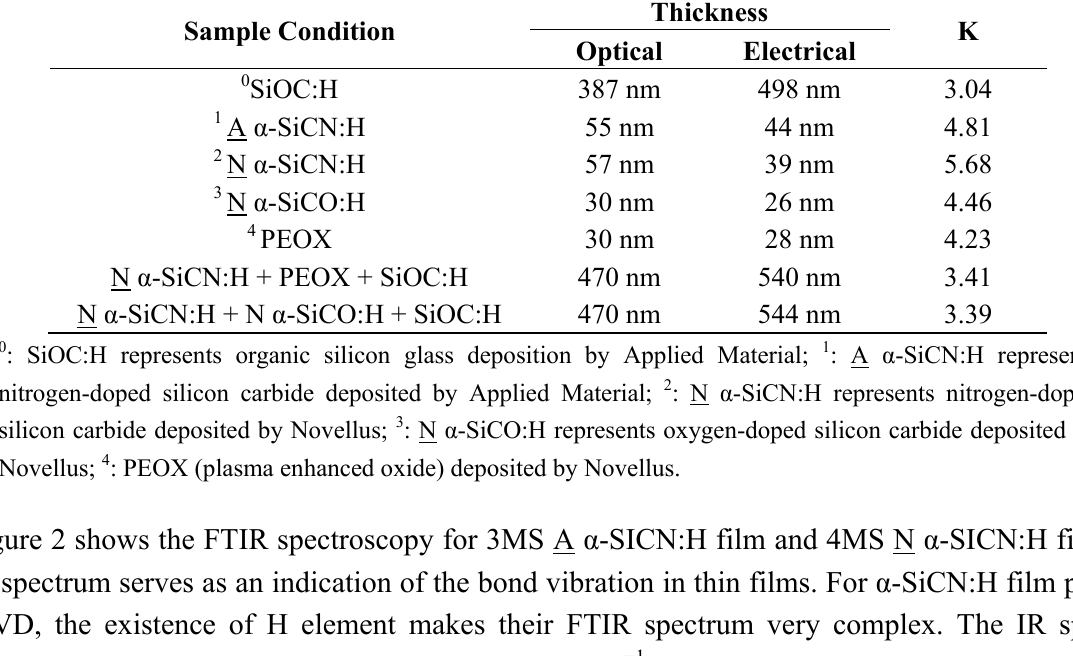
Table 2. Dielectric constant k measurements. Sample